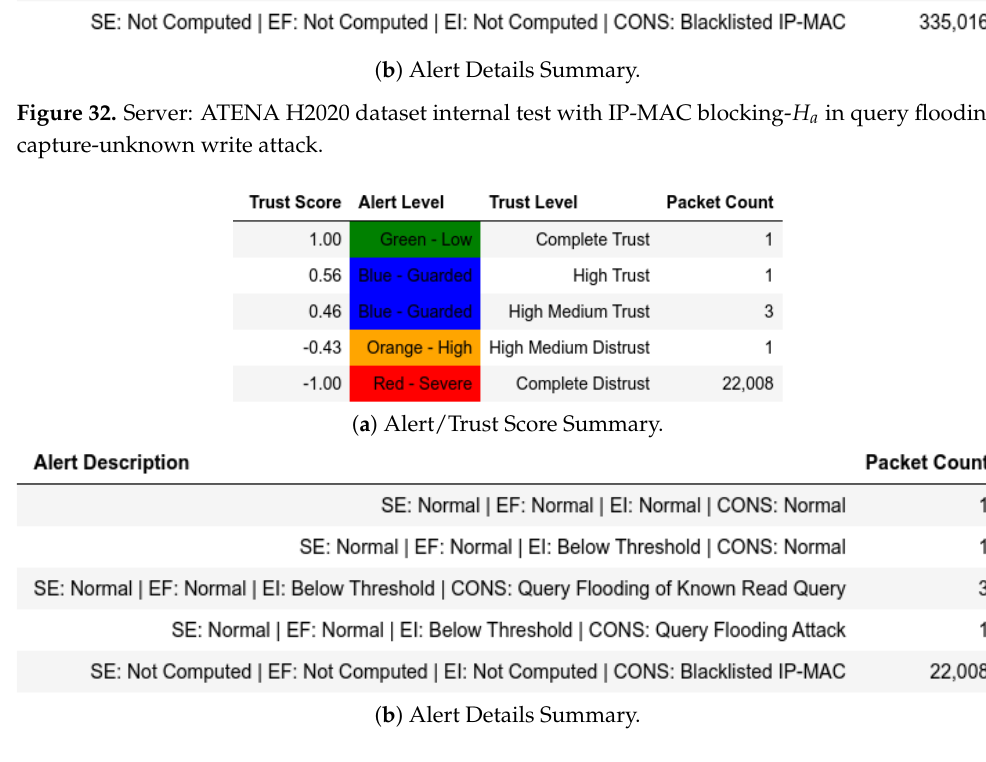
Figure 33. Server: ATENA H2020 dataset internal test with IP-MAC blocking- H a in query flooding capture-query flooding of known